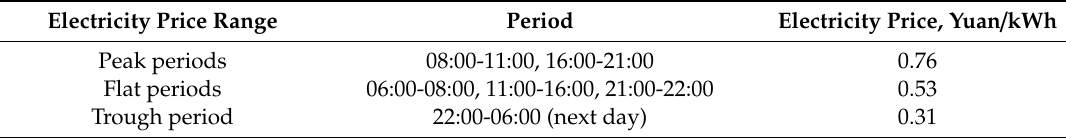
Table 4. TOU electricity pricing in steel plant (24-h